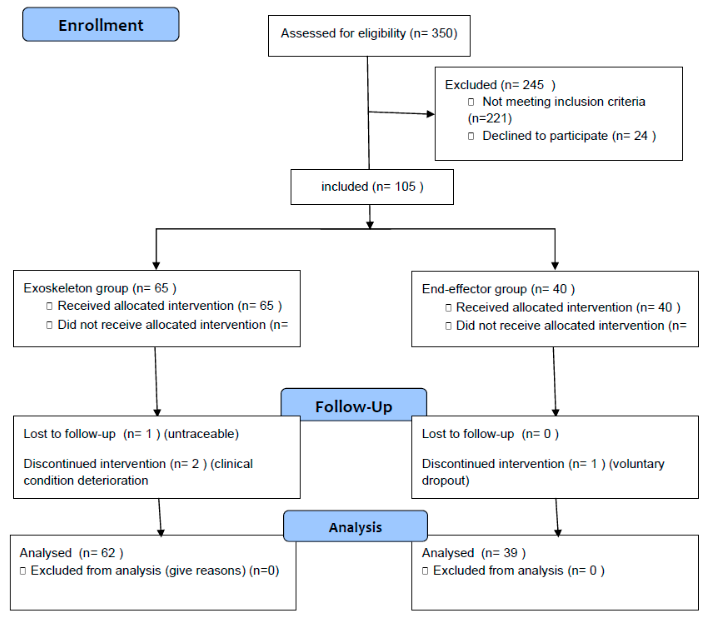
Figure 1. Patients’ flow diagram.